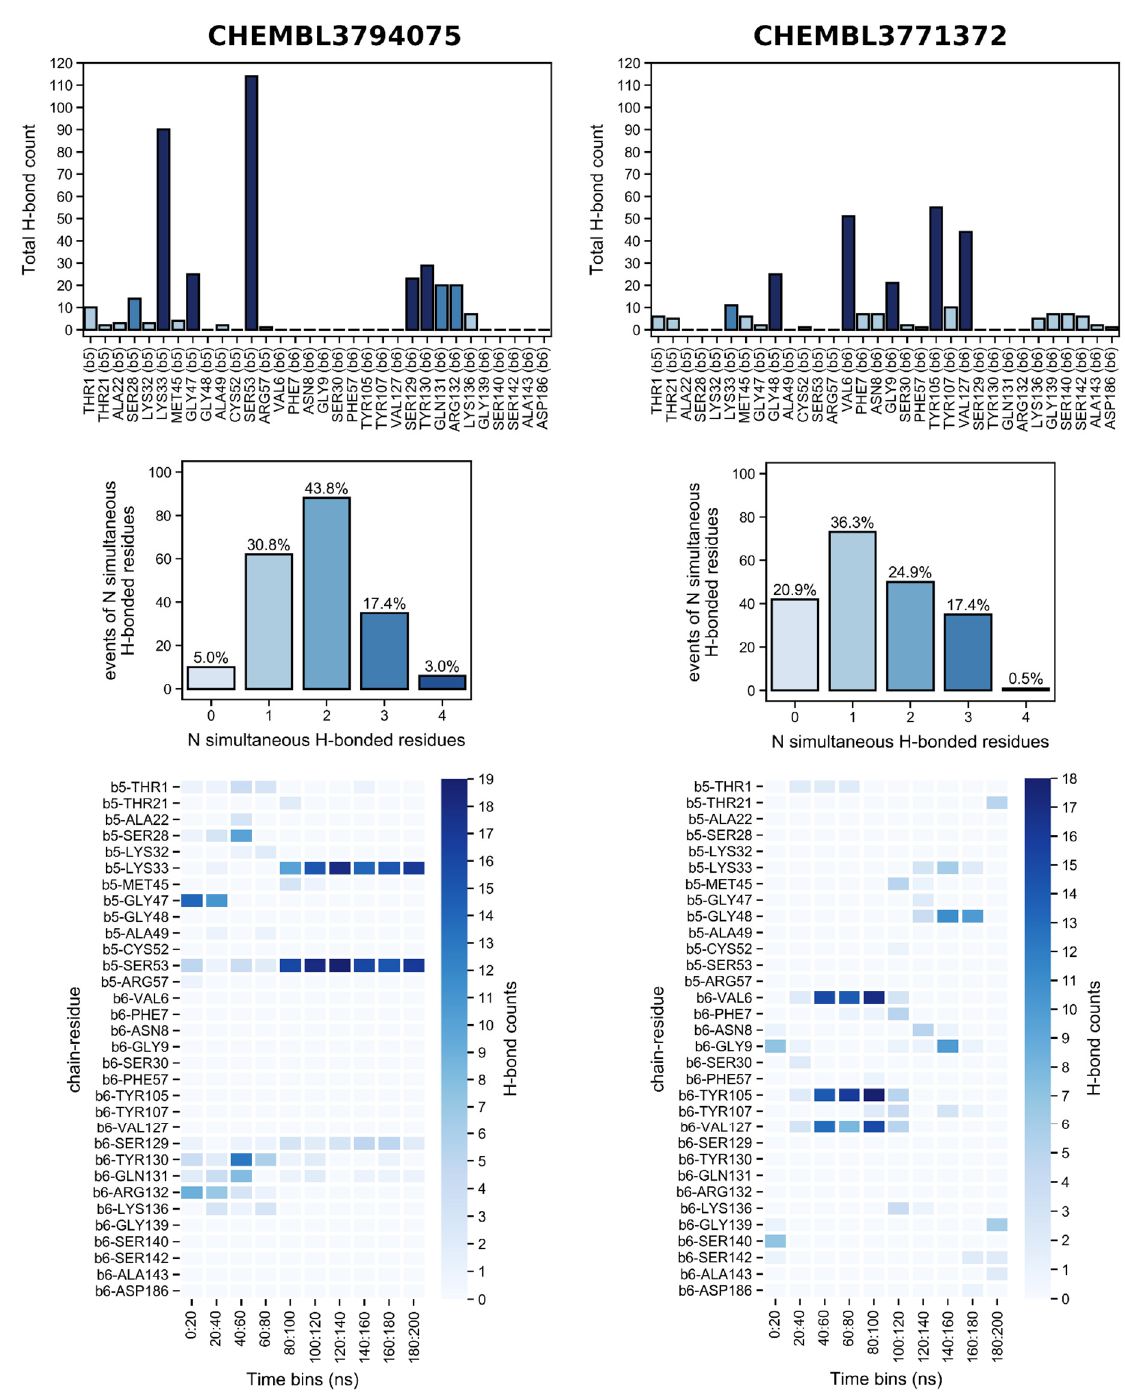
Figure 20. Hydrogen bonds established with P20S by the two hit compounds obtained from docking, throughout the 200 ns simulation. For ease of visualisation, the bar plot of total H-bond counts shows higher counts in increasingly darker blue: <10 H-bonds (light blue), 10–20 H-bonds (medium blue), >20 H-bonds (dark blue).